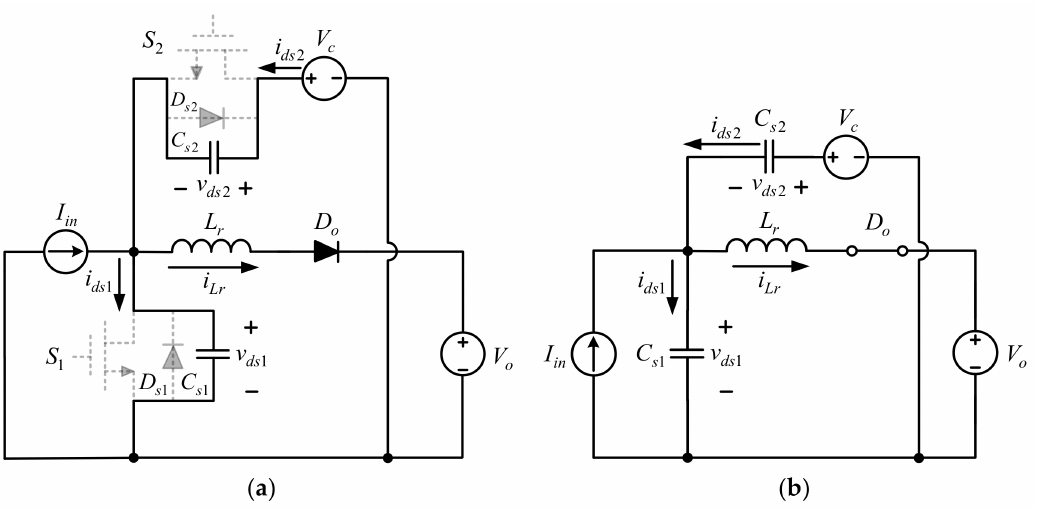
Figure 9. ( a ) Current path for stage 6; ( b ) equivalent of ( a ). Three stage equations can be obtained as shown in Figure